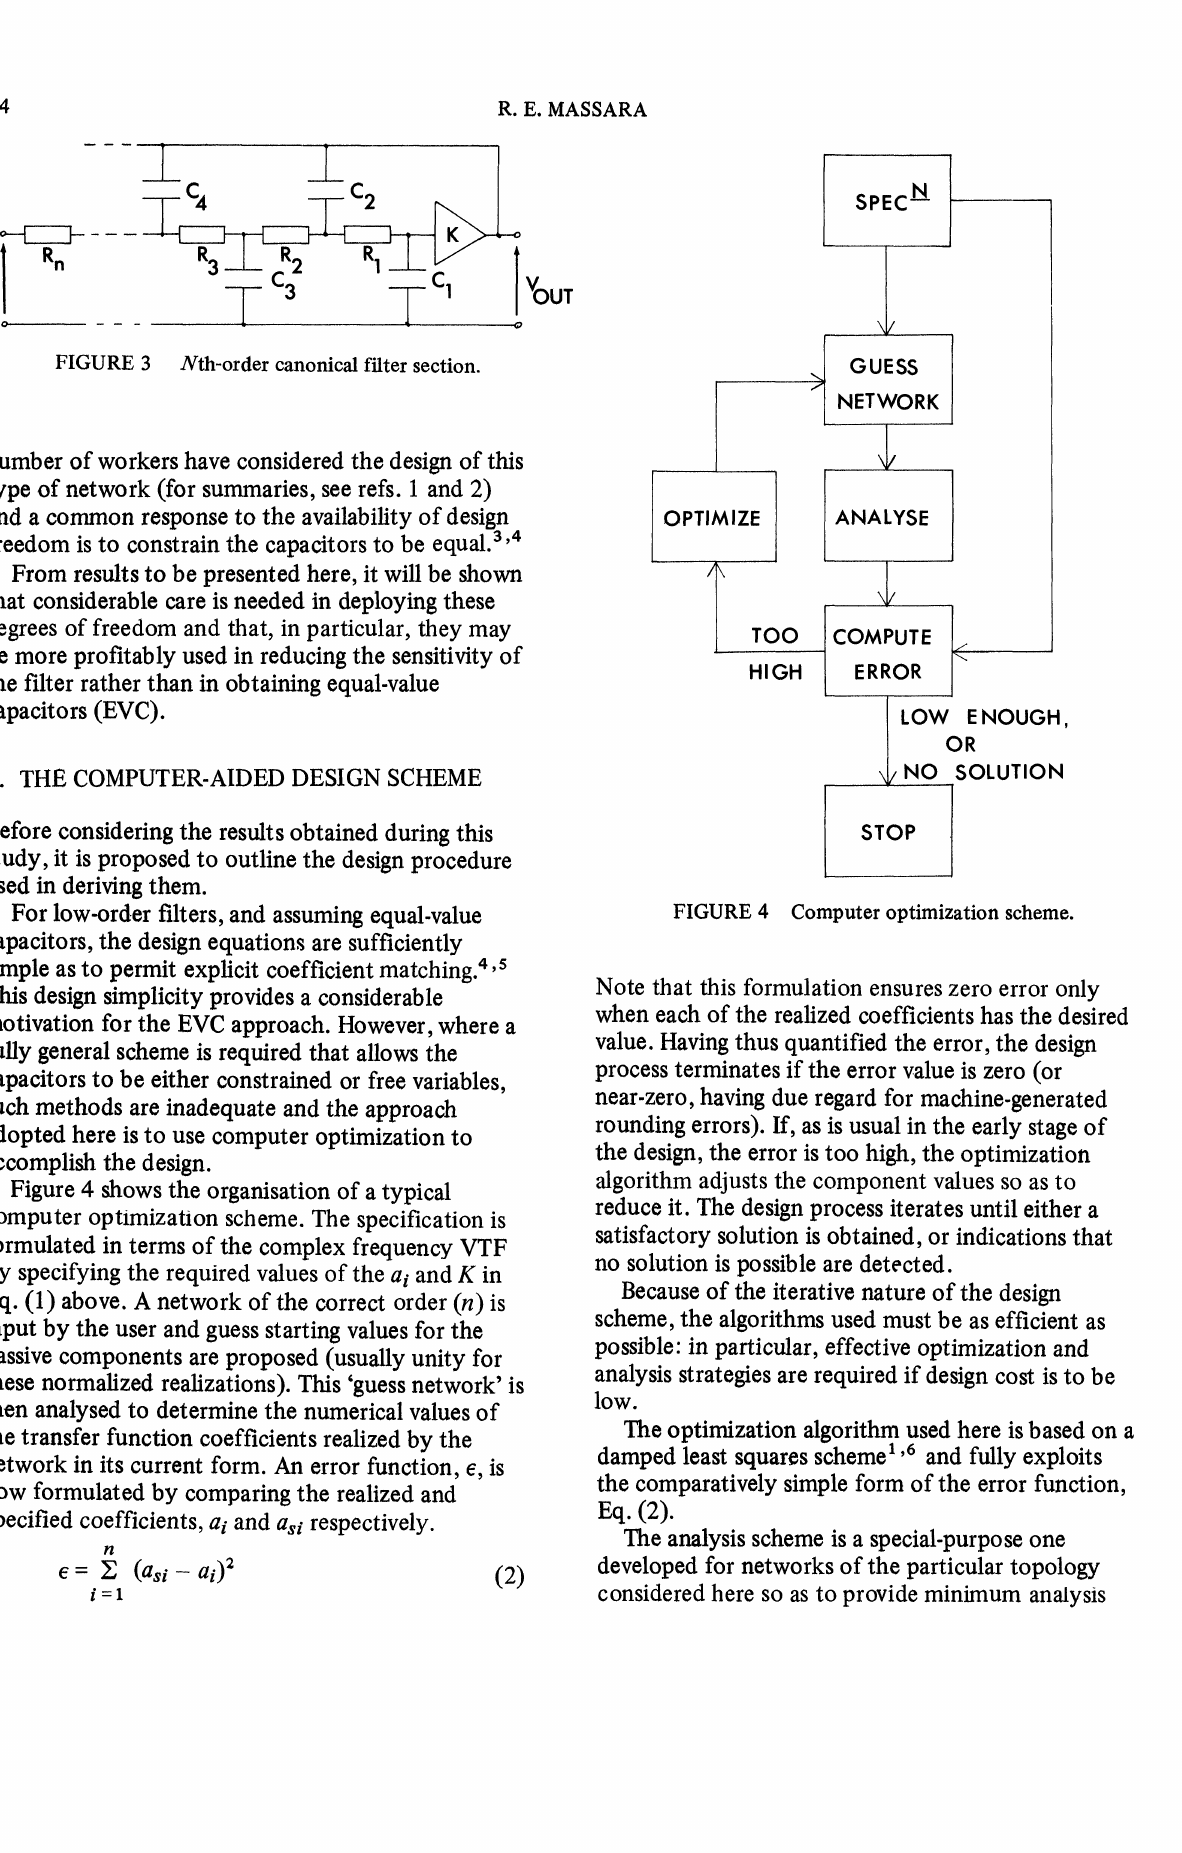
FIGURE 3 Nth-order canonical filter section.